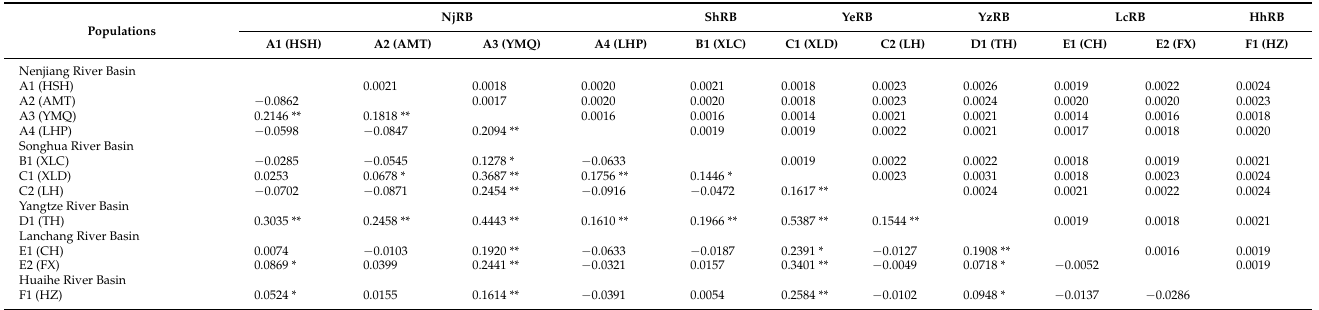
Table 3. The F ST value (below diagonal) and genetic distance (above diagonal) among 11 populations of N. taihuensis based on COI sequence data. genetic differentiation occurred between the LH and LHP populations (Fst = − 0.0916, Table 3). The UPGMA phylogenetic tree was constructed based on the genetic distance between the 11 populations. The genetic distance ranged from 0.0014 to 0.0031, and there was no significant geographical population pattern between populations. TH and XLD were the most distant (0.0031), while YMQ and XLD were the shortest (0.0014). LH was clustered into a single branch (Figure 2).